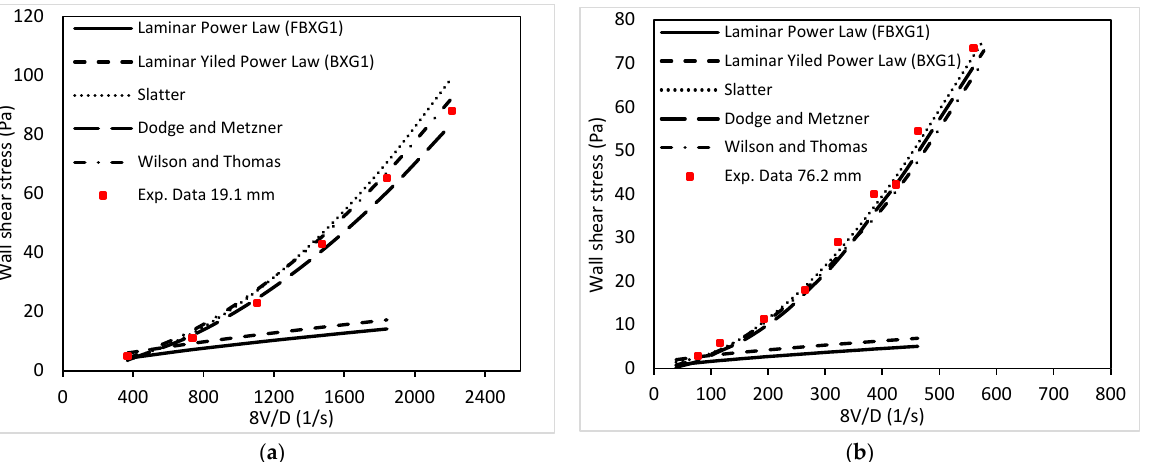
Figure 8. Comparison between predictions and experimental data of turbulent fl ow for low-concen- trated FBXG1, BXG1 power-law fl uids, and BXG1 Herschel–Bulkley fl uids: ( a ) pipe diameter 19.1 mm, ( b ) pipe diameter 76.2 mm .